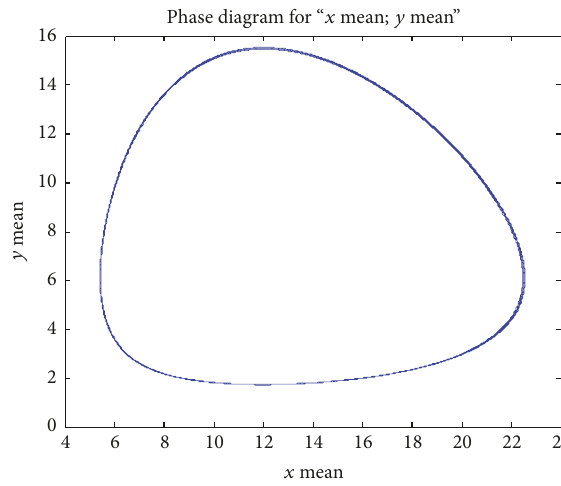
2 , 𝛿 = 4 , 𝑟 = 1 , and 𝐾 = 1 . Figure 2 shows the trajectory of the solutions of the system of (1) with initial conditions 𝑥(0) = 20 and 𝑦(0) = 3 and with the same the parameter values 𝑚 = 5 , 𝐴 = 18 , 𝛾 = 2 , and 𝛿 = 4